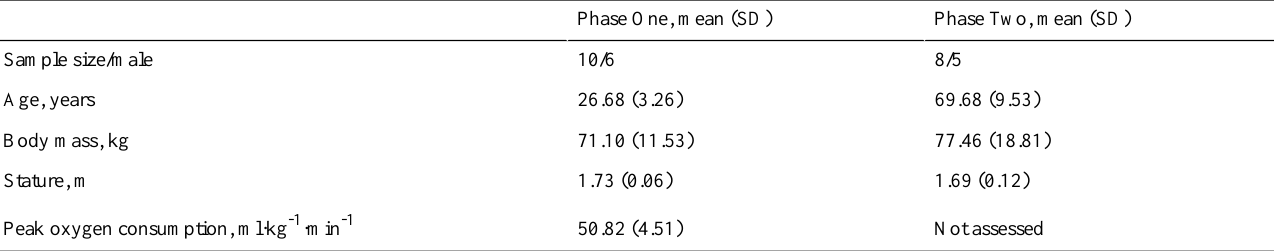
Phase Two, mean (SD)Phase One, mean (SD)